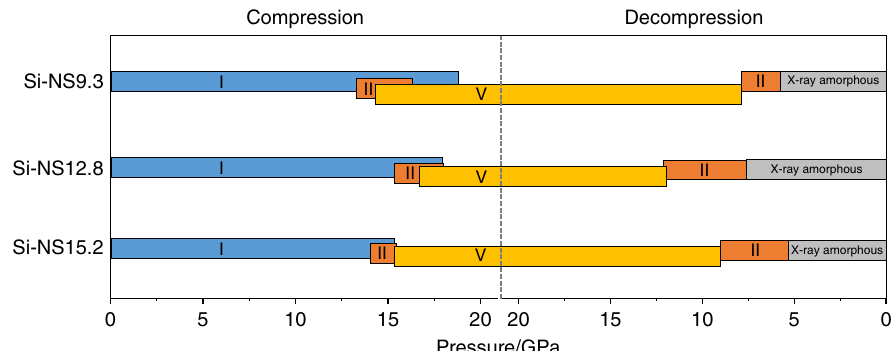
Fig. 3 Transition sequence of silicon nanosheets. Phase transitions for Si-NS9.3, Si-NS12.8, and Si-NS15.2 during compression up to 20.5(1), 21.0(1), and 20.5(1) GPa, respectively, and then decompression